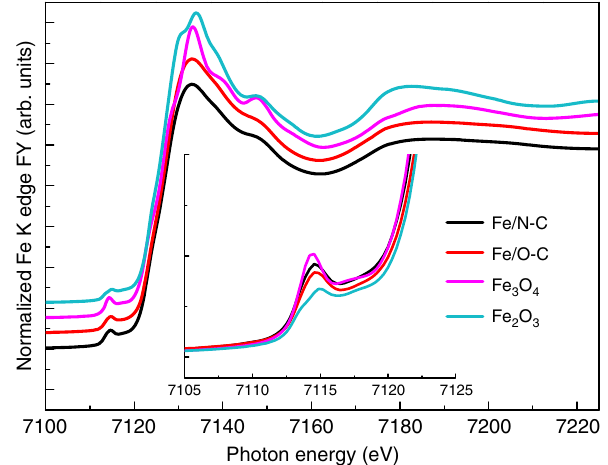
Fig. 1 Fluorescence yield (FY) Fe K edge XANES spectra of the Fe/O-C and Fe/N-C samples. FY Fe K edge XANES spectra in comparison with Fe 2 O 3 and Fe 3 O 4 reference samples, measured in